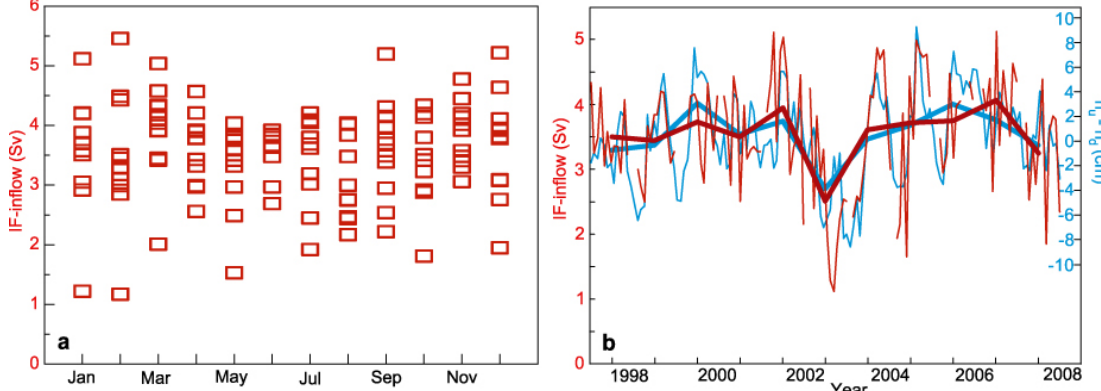
Fig. 3. Volume transport of Atlantic water across the IFR (red) plotted against the month (a) and time (b) of observation. On (b) , the blue curves show the SLH difference across the IFR as measured by h u − h d (defined in Fig. 11). Thin lines: monthly (four weeks) averages. Thick lines: annual averages (summer to summer).